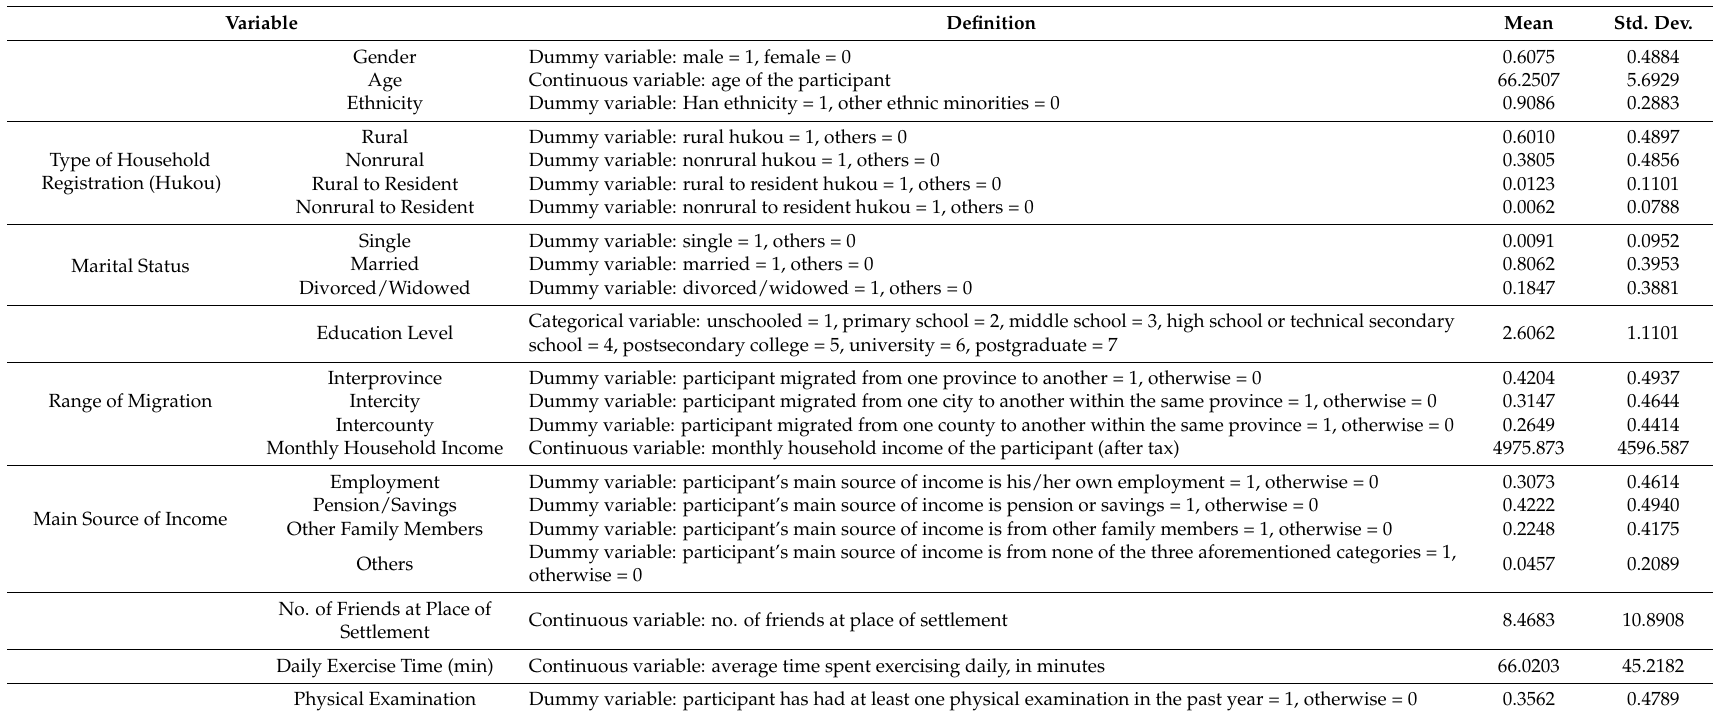
Table 3. Definitions of controlled variables and description of the